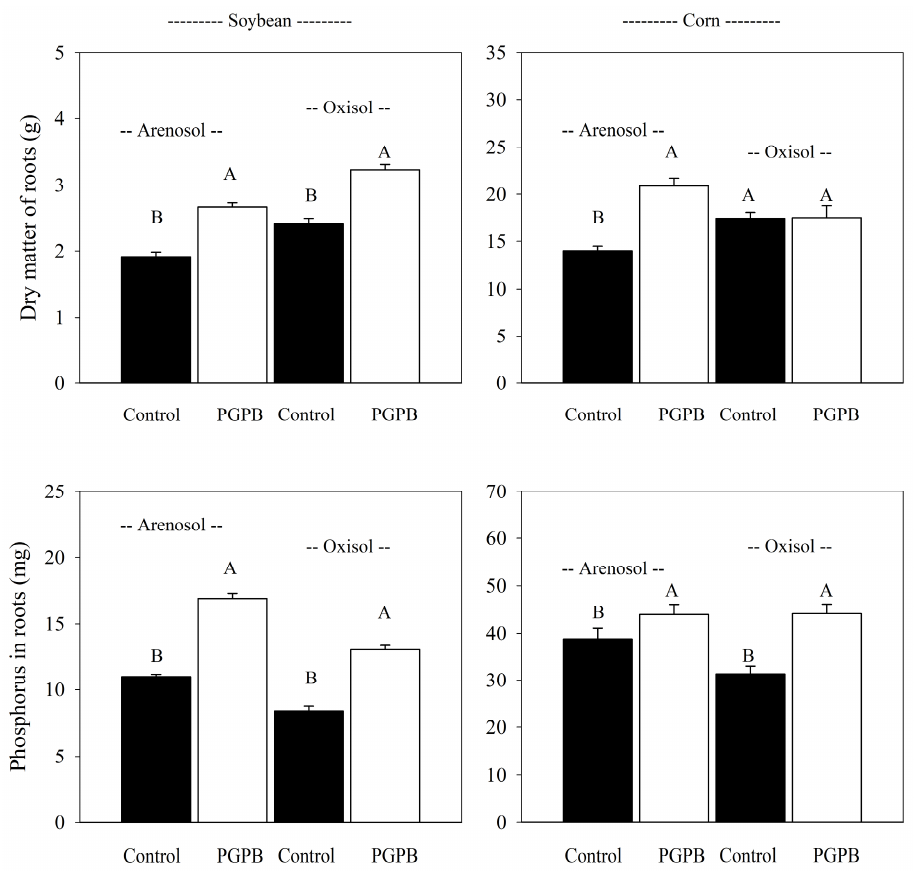
Figure 3. General average of root dry matter and phosphorus in roots of corn and soybean cultivated in an oxisol and arenosol with the application of monoammonium phosphate sprayed with plant growth-promoting bacteria (PGPB). Deviation bars indicate the standard error from the mean. The general averages of soils and crops were tested by the t -test ( p -value < 0.05), and different uppercase letters represent the comparison between averages.